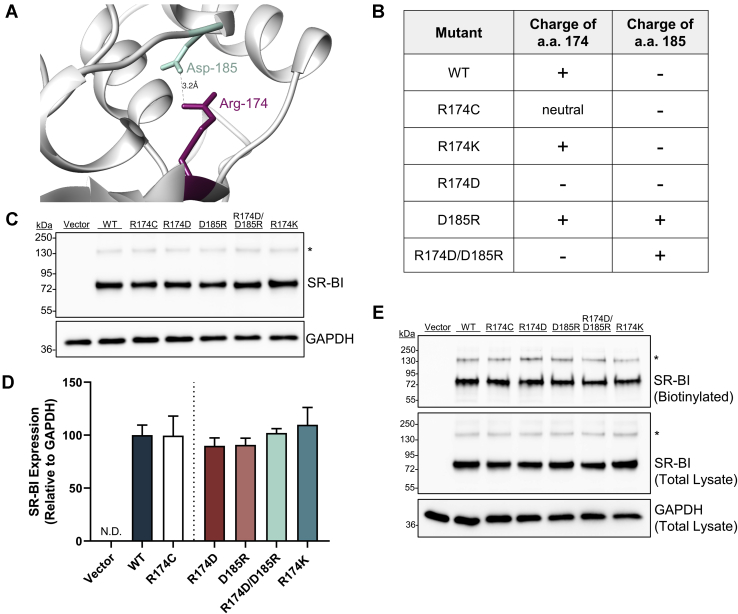
Arginine-174 and aspartate-185 may interact through a salt bridge. A: Homology modeling suggests a possible salt bridge interaction between residues Arg-174 (magenta) and Asp-185 (light green) with an approximate distance of 3.2 Å, as calculated by Chimera software. B: Additional mutant constructs were generated to disrupt or retain the putative salt bridge. C: SR-BI immunoblot analysis was performed on cell lysates (10 μg) from COS-7 cells transiently transfected with empty vector or mutant SR-BI. D: SR-BI expression was quantified relative to GAPDH loading control by densitometry. E: Cell surface levels of SR-BI (in 100 μl total lysate), following sulfo-NHS-LC biotinylation of transiently transfected COS-7 cells, were determined by immunoblot analysis. The additional mutants are colored as follows: salt bridge-disrupting mutants (R174D-SR-BI and D185R-SR-BI) in dark red and light red, the charge swap mutant (R174D-SR-BI/D185R-SR-BI) in light teal, and the conservative mutant (R174K-SR-BI) in dark teal. Immunoblots in panels C and E were performed under reducing conditions. Data in panel D represent the mean ± SEM of three independent transfections (n = 3), relative to average WT-SR-BI expression levels (WT = 100%). As determined by one-way ANOVA, no statistical significance was observed between the means for WT-SR-BI and mutant SR-BI receptors. The immunoblots in panels C and E are each representative of three independent transfections (n = 3). SR-BI, scavenger receptor class B type I.